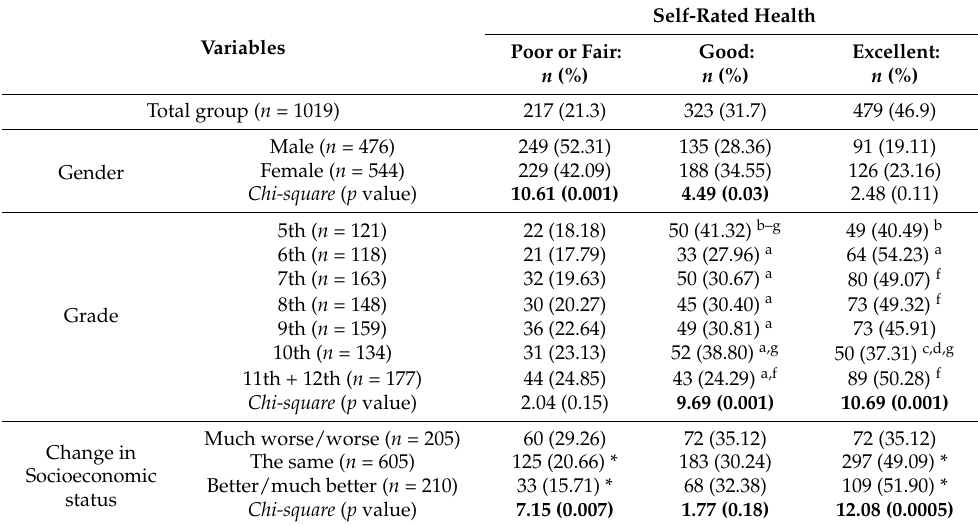
Table 2. Participants’ self-rated health according to sociodemographic characteristics.